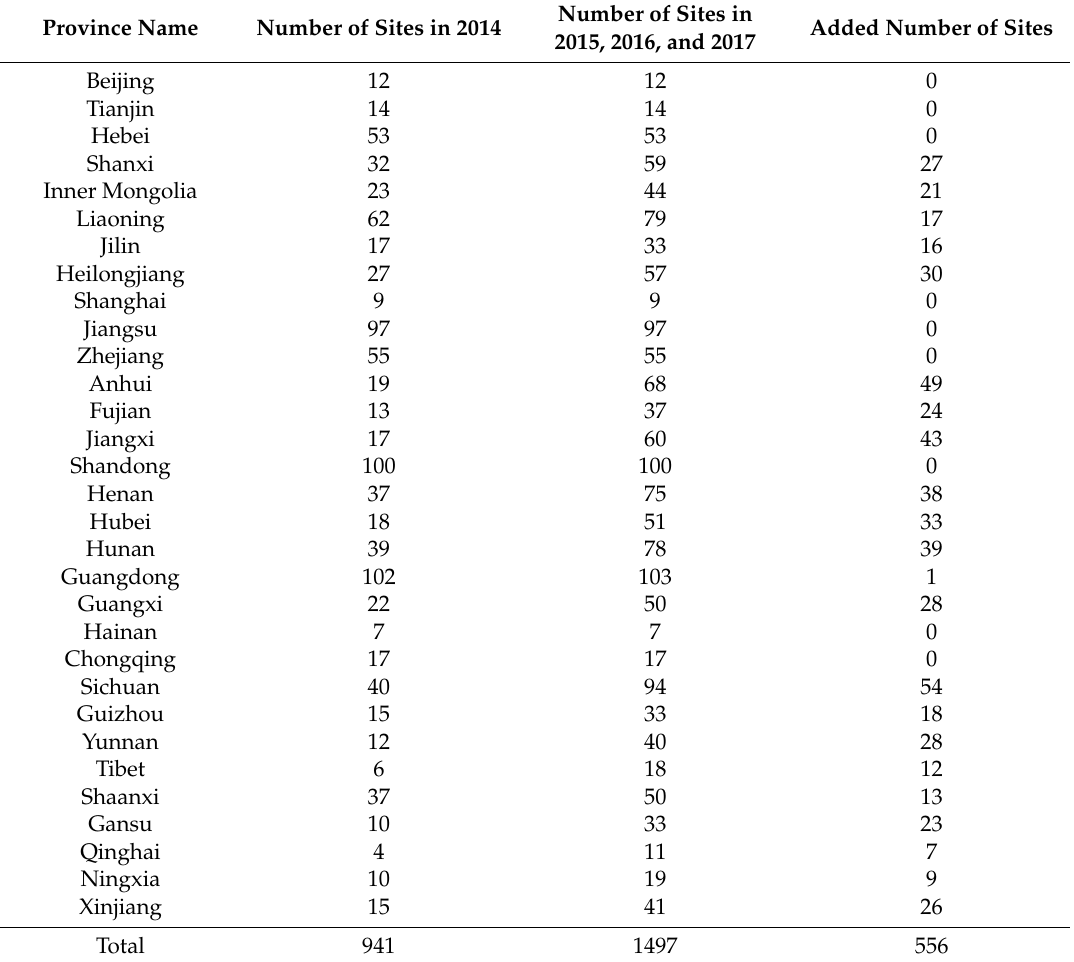
Table 1. The number of PM 2.5 ground monitoring sites in 31 provinces in mainland China in 2014, 2015, 2016 and